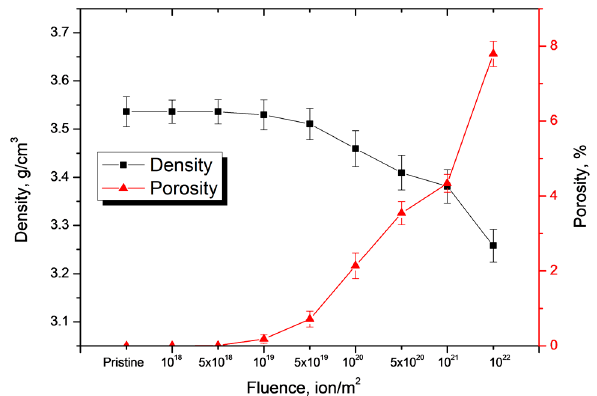
Figure 5. Change in the density and porosity of ceramics depending on the irradiation fluence.